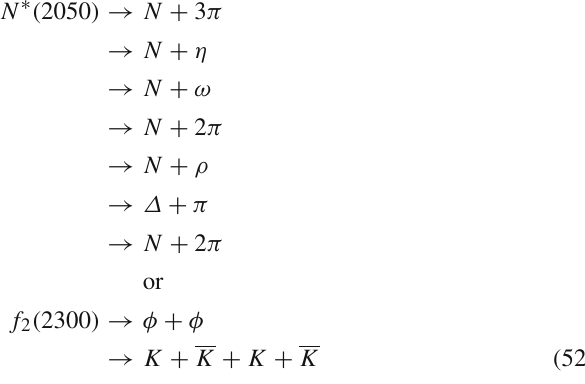
Fig. 143 Inverse slopes T for constant m T − m as a function of